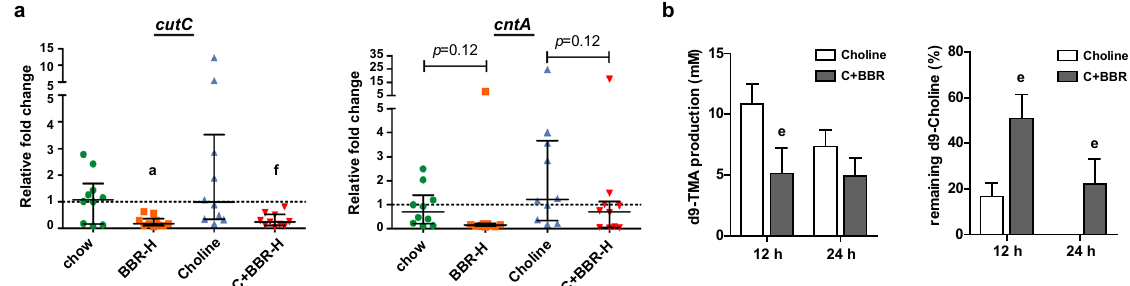
Fig. 5 BBR regulated gut microbiota functional genes cutC and cntA for TMA production in ApoE KO mice. ApoE KO mice were fed choline diet for 4 months with or without BBR ( n = 10 for each group). a The relative fold change of abundances of cutC and cntA in cecal content samples of ApoE KO mice were measured by qPCR, normalized to the 16S rRNA gene abundance from each sample. Error bars show the median with interquartile ranges using Kruskal – Wallis H test. b The intestinal microbiota of the cecal contents from choline-fed ApoE KO mice with or without BBR treatment (100 mg/kg) were used for an ex vivo assay. In the anaerobic fermentation, the transformation of d9-choline to d9-TMA was measured at 12 and 24 h, respectively. Values are presented as means ± SEM ( n = 10). a p < 0.05 (versus chow-diet group); e p < 0.05; f p < 0.01 (versus choline-diet